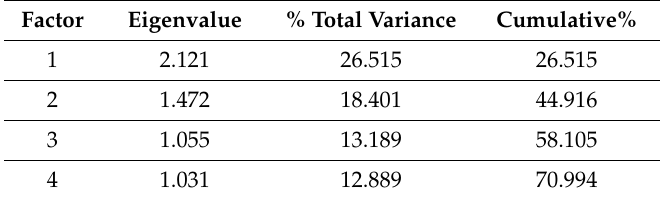
Table 3. Factor extraction based on eigenvalues: principal components (Kaiser criterion >